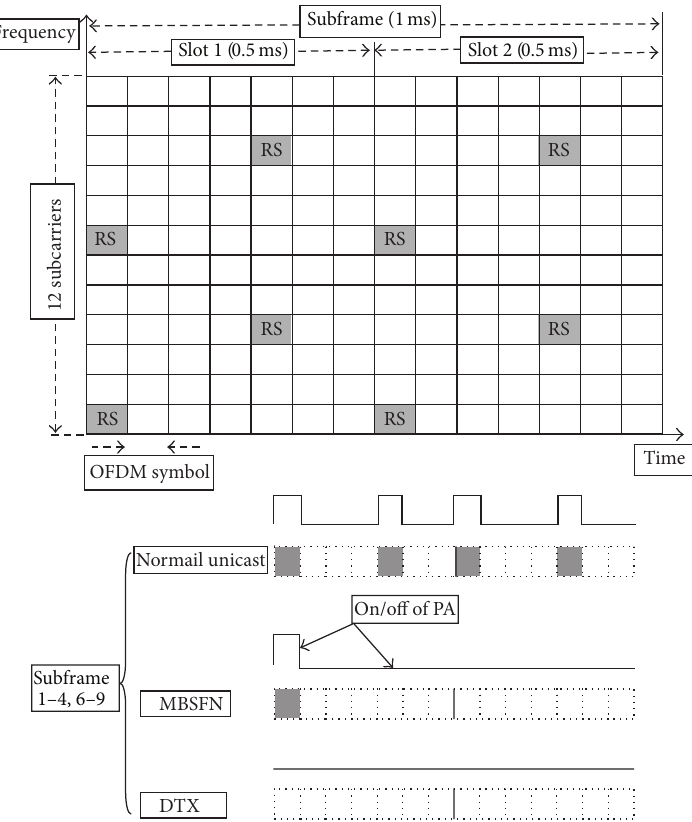
Figure 6: Time domain solution during idle and low traffic